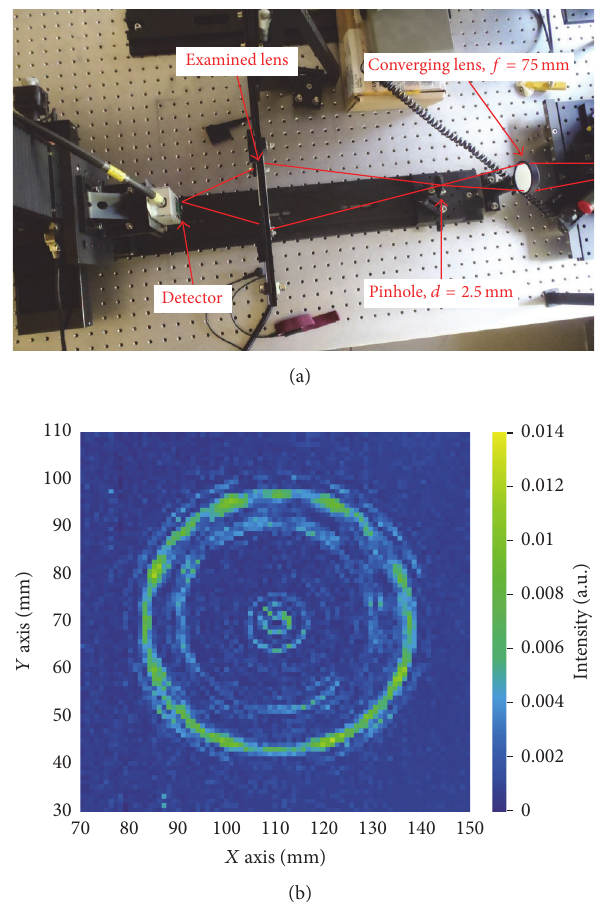
Figure 11: The experimental setup (a) and the intensity distribution registered in the focal plane